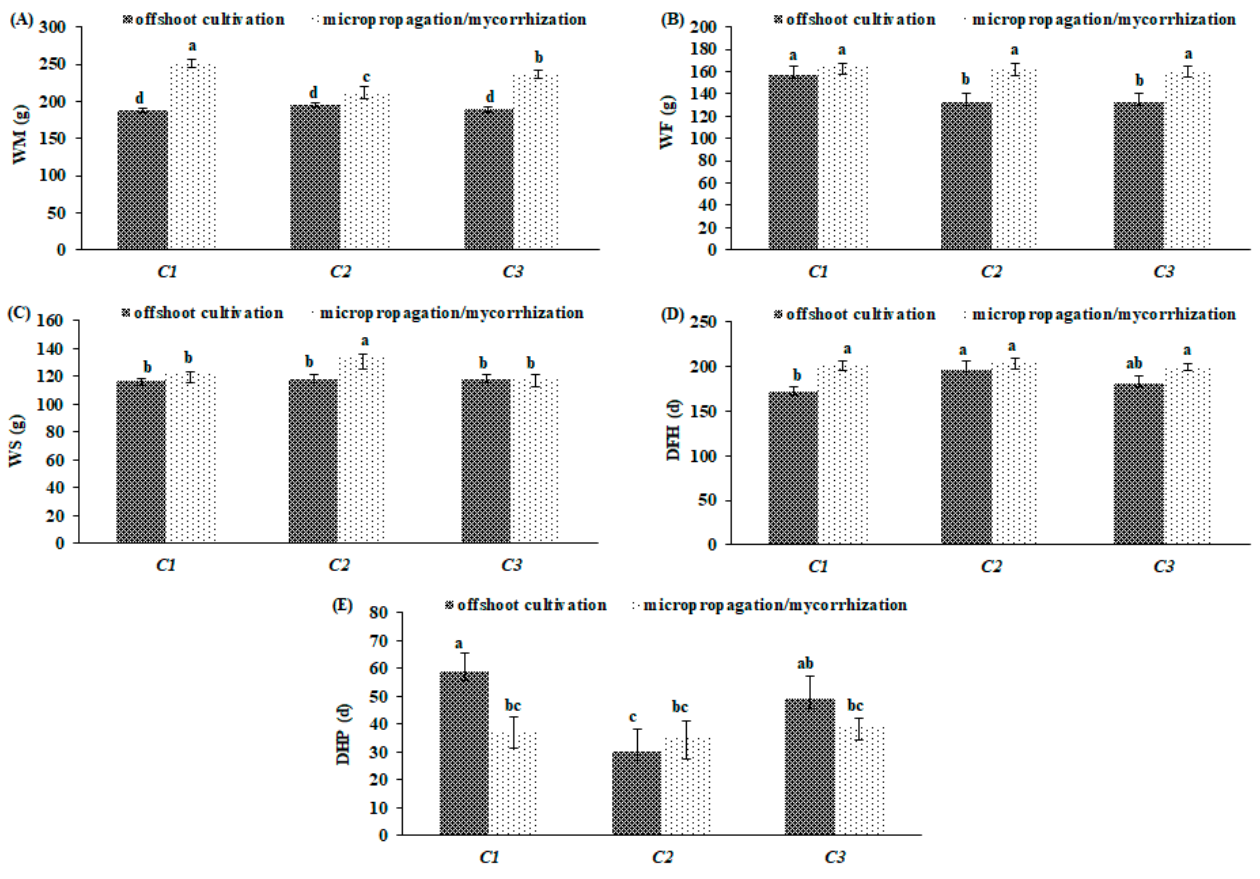
Figure 4. Bio-agronomical traits in clone of globe artichoke plants as affected by ‘genotype × propagation method’. Different letters indicate significance at Fisher’s protected LSD (least significant difference) test ( p ≤ 0.05). Vertical bars indicate ± standard deviation. WM, main head fresh weight ( A ); WF, first order head fresh weight ( B ); WS, second order head fresh weight ( C ); DFH, first harvest ( D ); DHP, harvest period ( E ). As shown by the ANOVA, WF, WS, and NH were also associated with a significant ‘propagation method × season’ interaction (Table 1). Going from season I to season II, both offshoots cultivation and micropopagated/mycorrhized plants consistently increased their NH (+39 and +12%, respectively) (Figure 3A). With reference to WF and WS, offshoots cultivated and micropopagated/mycorrhized plants exhibited a different behaviour. Pass- ing from season I to season II, WF revealed significant differences only within offshoots cultivated plants. The same applied to the WS in the case of micropopagated/mycorrhized plants (Figure